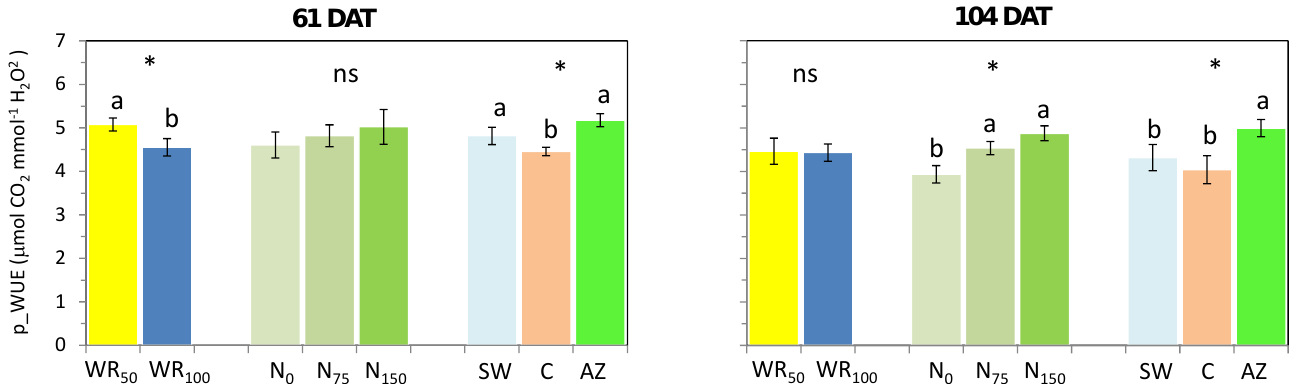
Figure 1. Effect of water regimes, nitrogen levels, and the application of biostimulants on the photosynthetic water use efficiency (p_WUE) of wild rocket 61 and 104 days after transplantation (DAT). WR 100 = restoration of 100% of ETc; WR 50 = restoration of 50% of ETc; N 0 = 0 kg ha -1 of N; N 75 = 75 kg ha -1 of N; N 150 = 150 kg ha -1 of N; C = control; AZ = application of azoxystrobin; SW = application of a seaweed extract-based biostimulant. The vertical bars indicate the standard deviation. ns, * indicate a non-significant or significant F-test at p < 0.05. Different letters indicate significantly different values according to the SNK test ( p = 0.05).